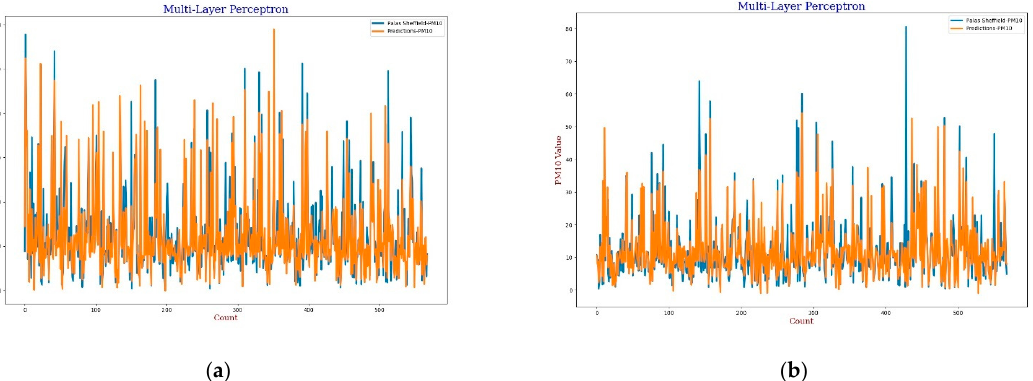
Figure 11. ( a ) MLP calibration plot for PM 10 using AH . Blue colour represents the reference data and orange colour represents the calibrated data; ( b ) MLP calibration plot for PM 10 using RH . Blue colour represents the reference data and orange colour represents the calibrated data.